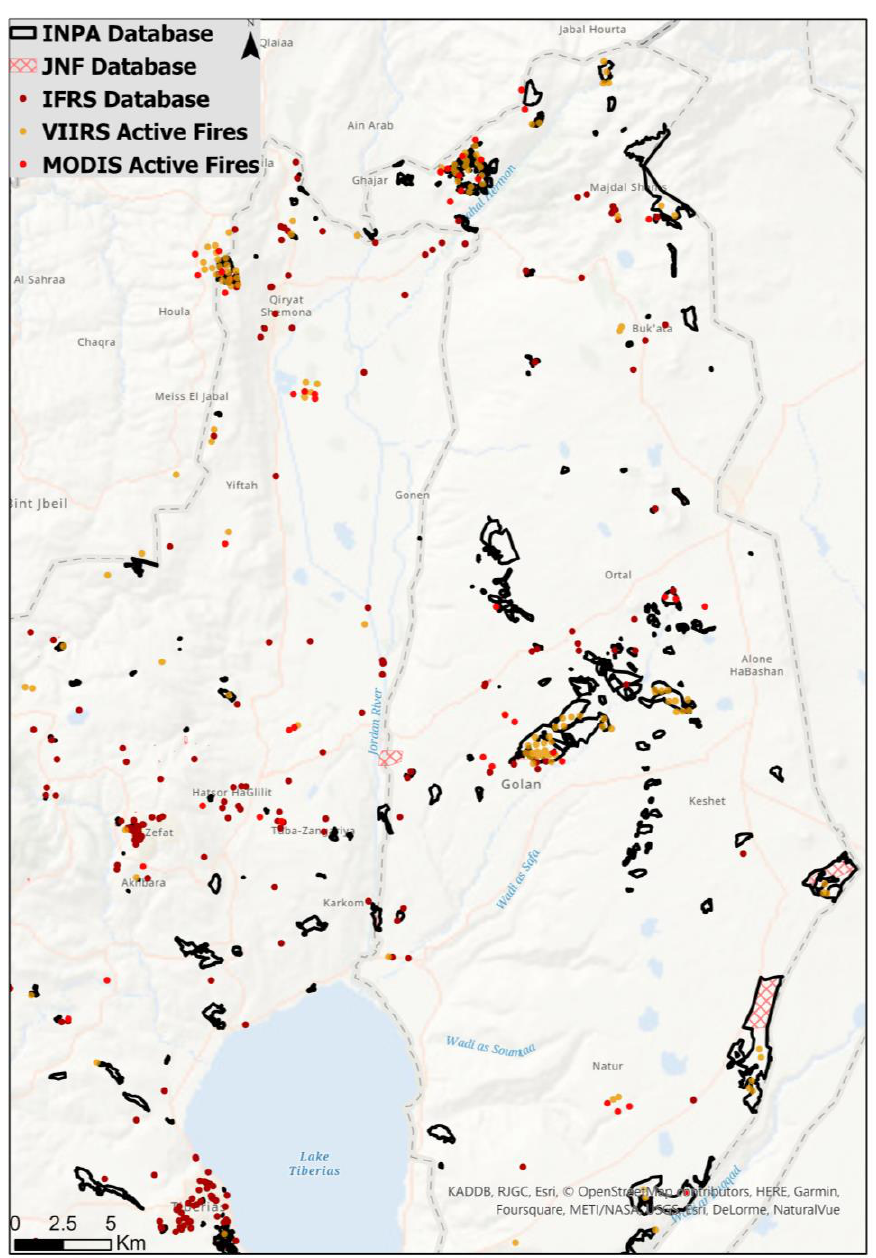
Figure 3. An example of records from the different wildfire databases used in this study (INPA, JNF, IFRS, and VIIRS and MODIS active fires). Data shown are for wildfires in northern Israel in 2020.